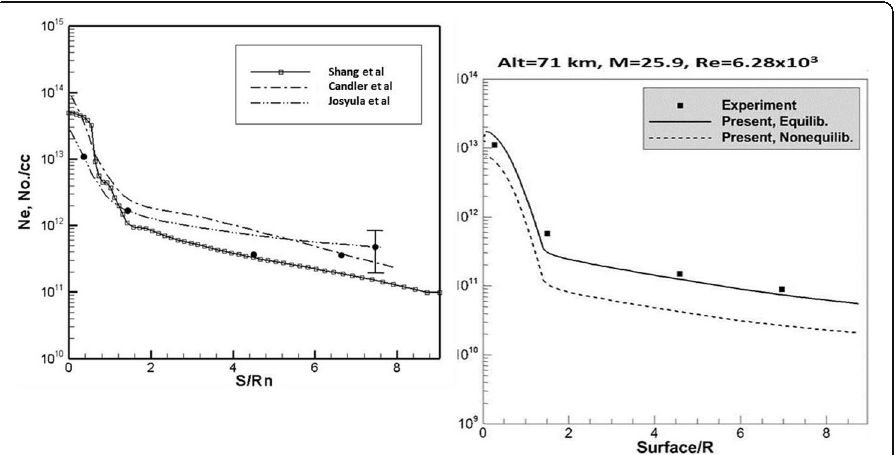
Fig. 8 Validating electron number density with flight data from RAM-C-II